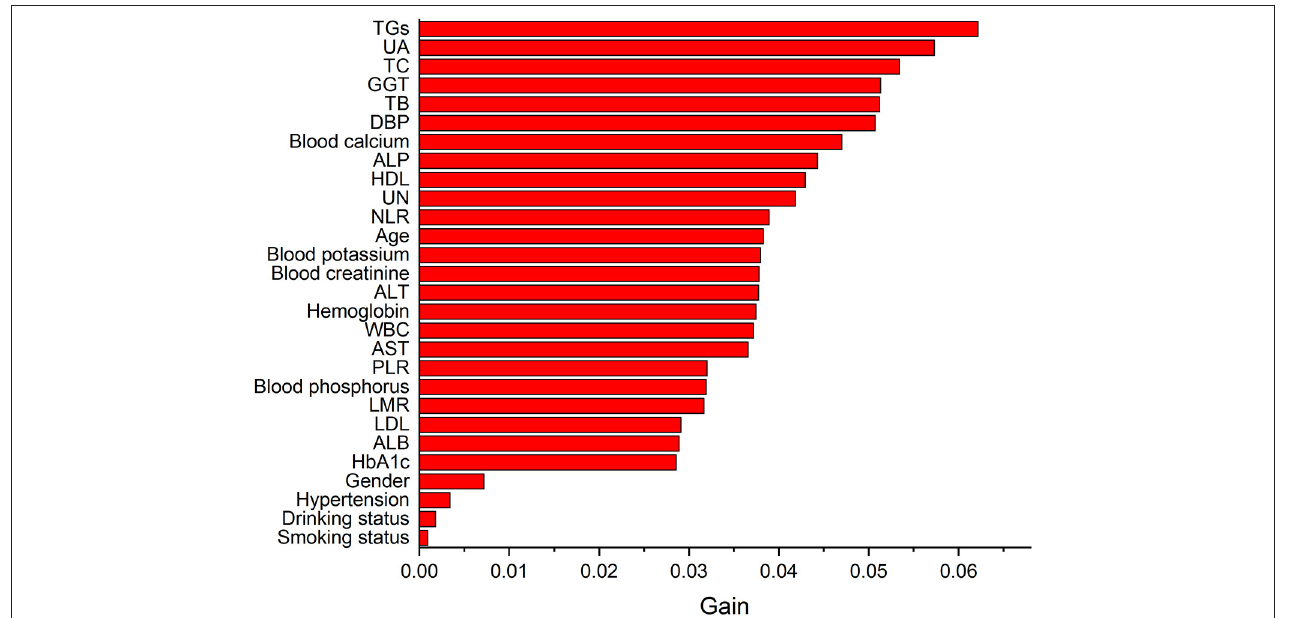
FIGURE 5 | Importance analysis of indexes in XGBoost